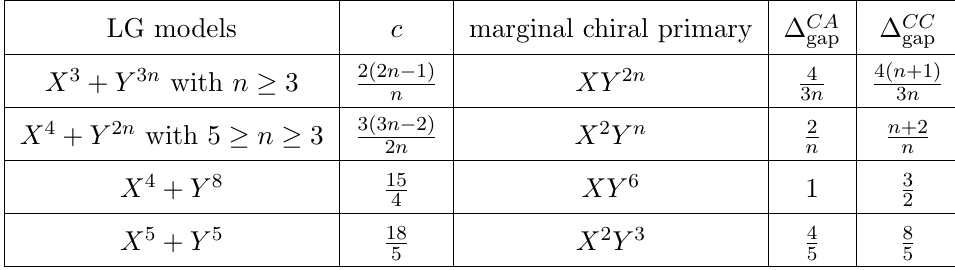
= 2 models with 3 < c < N